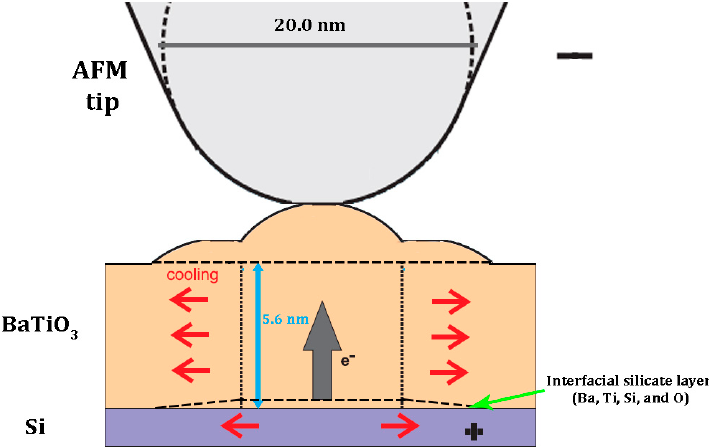
Figure 6. Schematic of the formation of modified structure of amorphous BaTiO 3 film under poling (not to sale).